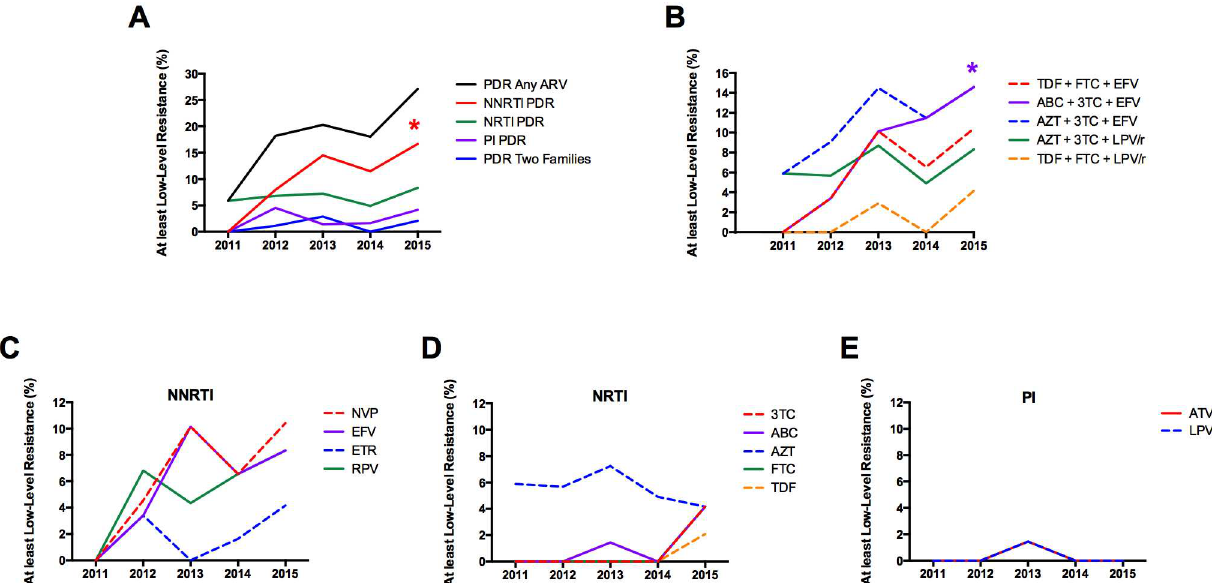
Fig 4. PDR temporal trends. PDR was estimated by year of enrolment using the HIVdb tool from Sanger sequences. Individualswith drug resistance were defined as those with at least low-levelresistance (Stanford penalty score (cid:21) 15) to any drug of the corresponding class. A. PDR temporal trends by drug class. B. PDR temporal trends for the most widely used antiretroviral regimens in Nicaragua. C-E PDR temporal trends by drug, dividedby drug class; only drugs currently used in clinical practice in the Nicaraguancontext are shown. * p < 0.05; linear regression, slope different to 0; the color corresponds to the significant